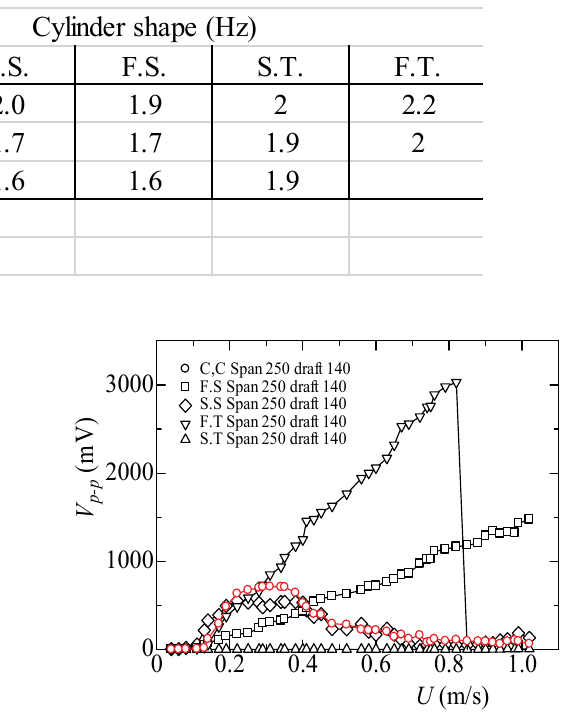
Fig. 5. An example of the output waveform from the power generation object Fig. 6. Relationship between flow velocity and output voltage, in the case of circular